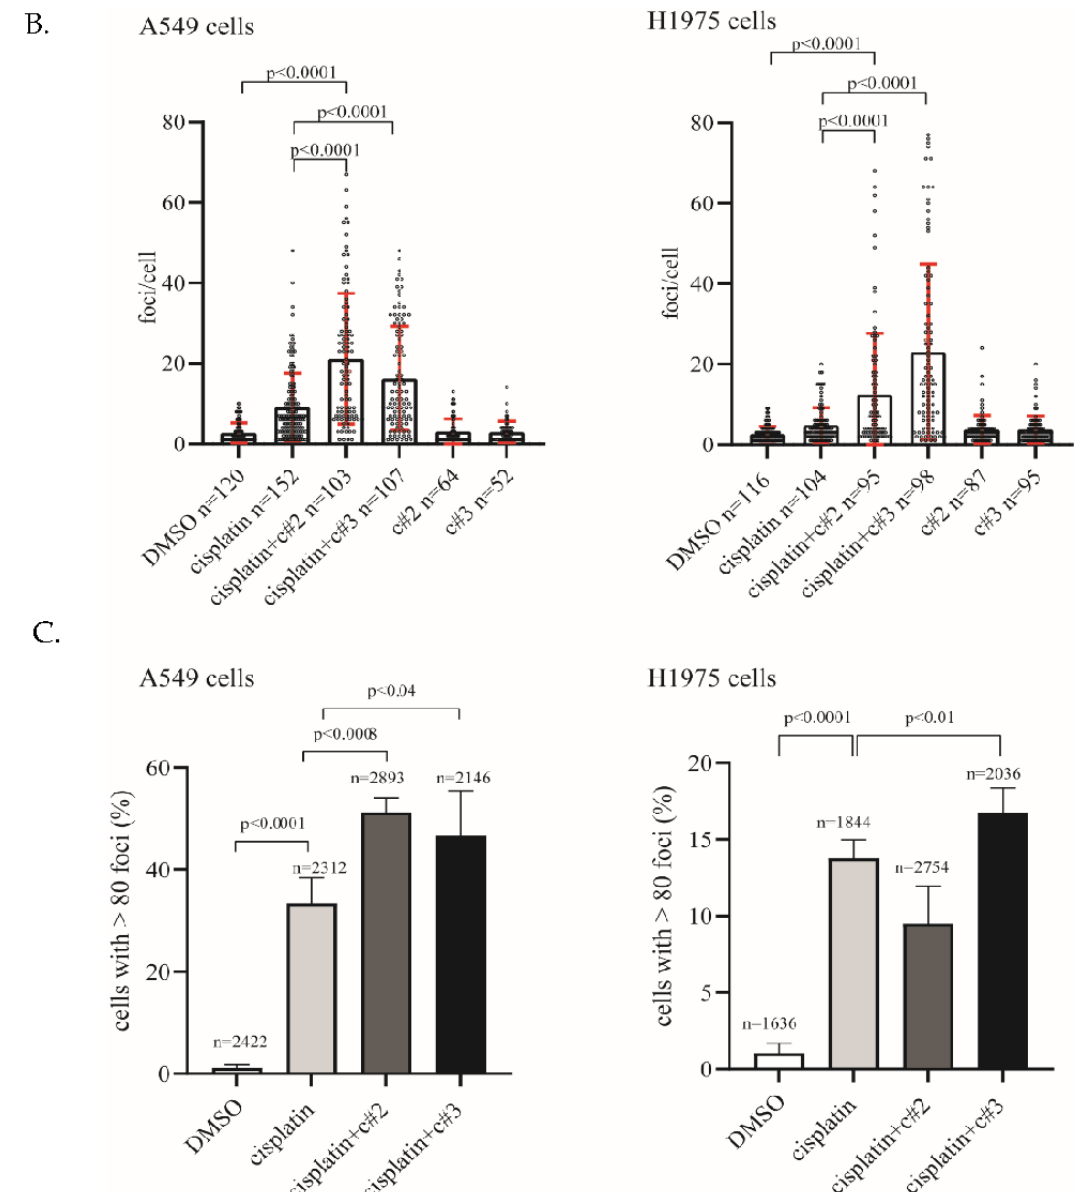
Figure 3. Compounds #2 and #3 increase DNA damage after combined treatment. ( A ) Representative figures of γ H2AX in A549 (left panel) cells and H1975 (right panel) with different treatments as indicated. ( B ) Quantification of A549 and H1975 cells foci/cell in each treatment. The total number of cells scored is indicated. Error bars = 1 SD, error bars represent 1 SD. p -value was calculated by two-tailed t -test. ( C ) Quantification of A549 (left panel) and H1975 (right panel) cells with more than 80 foci/cell in each treatment. The total number of cells scored is indicated. These data were derived from four captures, in each of which at least 400 cells were scored. SD = 1, error bars represent 1 SD, for the independently determined percentages from the two experiments. p -value was calculated using a one-tailed t -test. A549 cells were treated with 10 μ M cisplatin and H1975 cells with 5 μ M cisplatin. Both cell lines were treated with 50 μ M of c#2 or c#3.